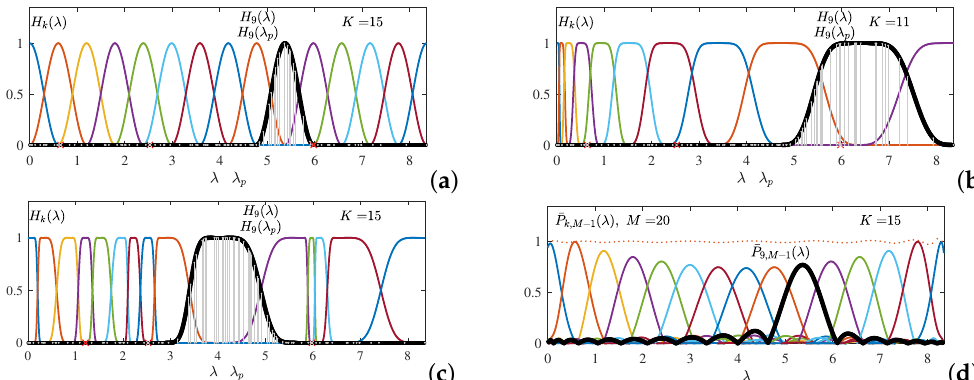
Figure 9. Transfer functions in the spectral domain. ( a ) The transfer functions corresponding to the Hann form terms for K = 15. ( b ) The spectral index-varying (wavelet-like) transfer functions whose terms are of half-cosine form, with K = 11. ( c ) The spectral domain signal adaptive transfer functions with K = 17. ( d ) Approximations of transfer functions from panel ( a ) using Chebyshev polynomials, with H 9 ( λ ) being designated by the thick black lines, whereas gray markers indicate the corresponding discrete values.